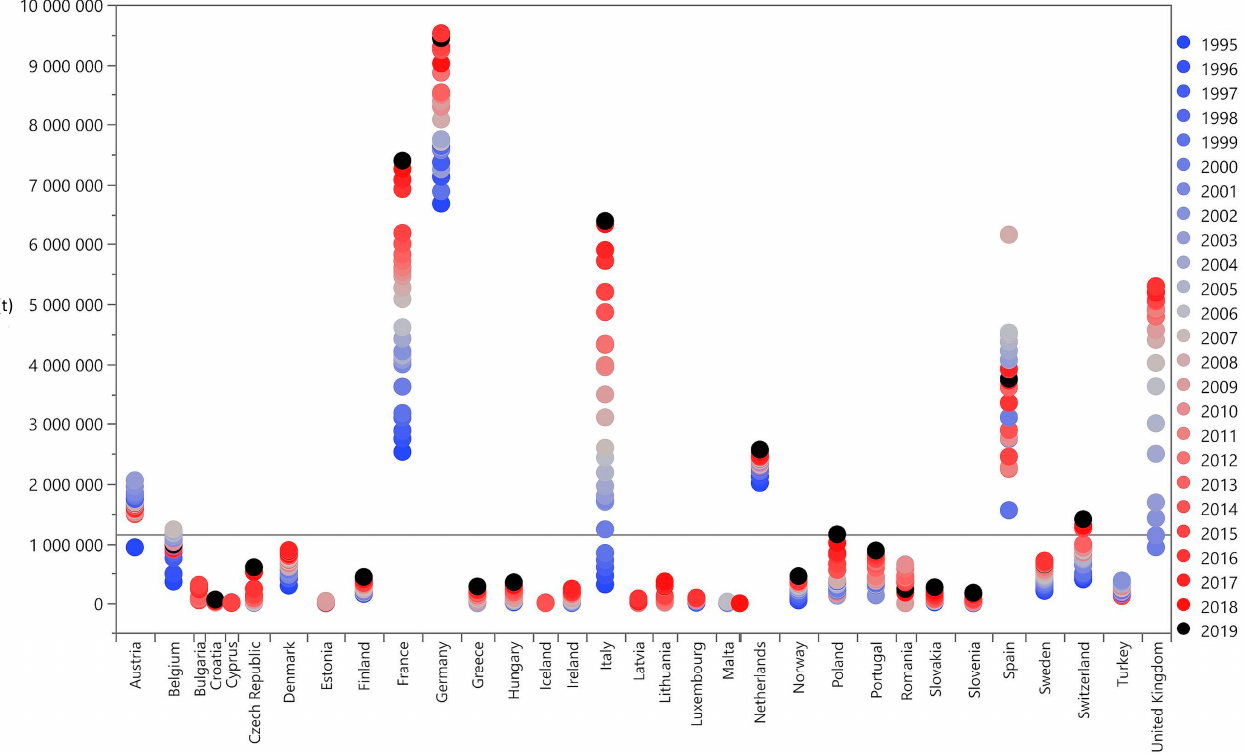
Figure 11. Composting and digestion of municipal waste in the EU for the years 1995–2019 .